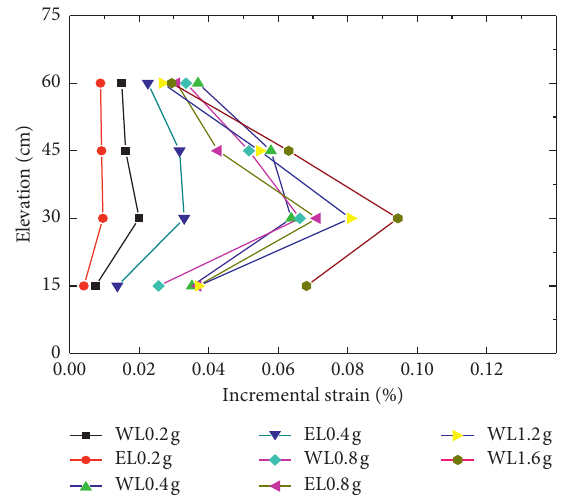
Figure 11: Distributions of strain in T 1 for specimen